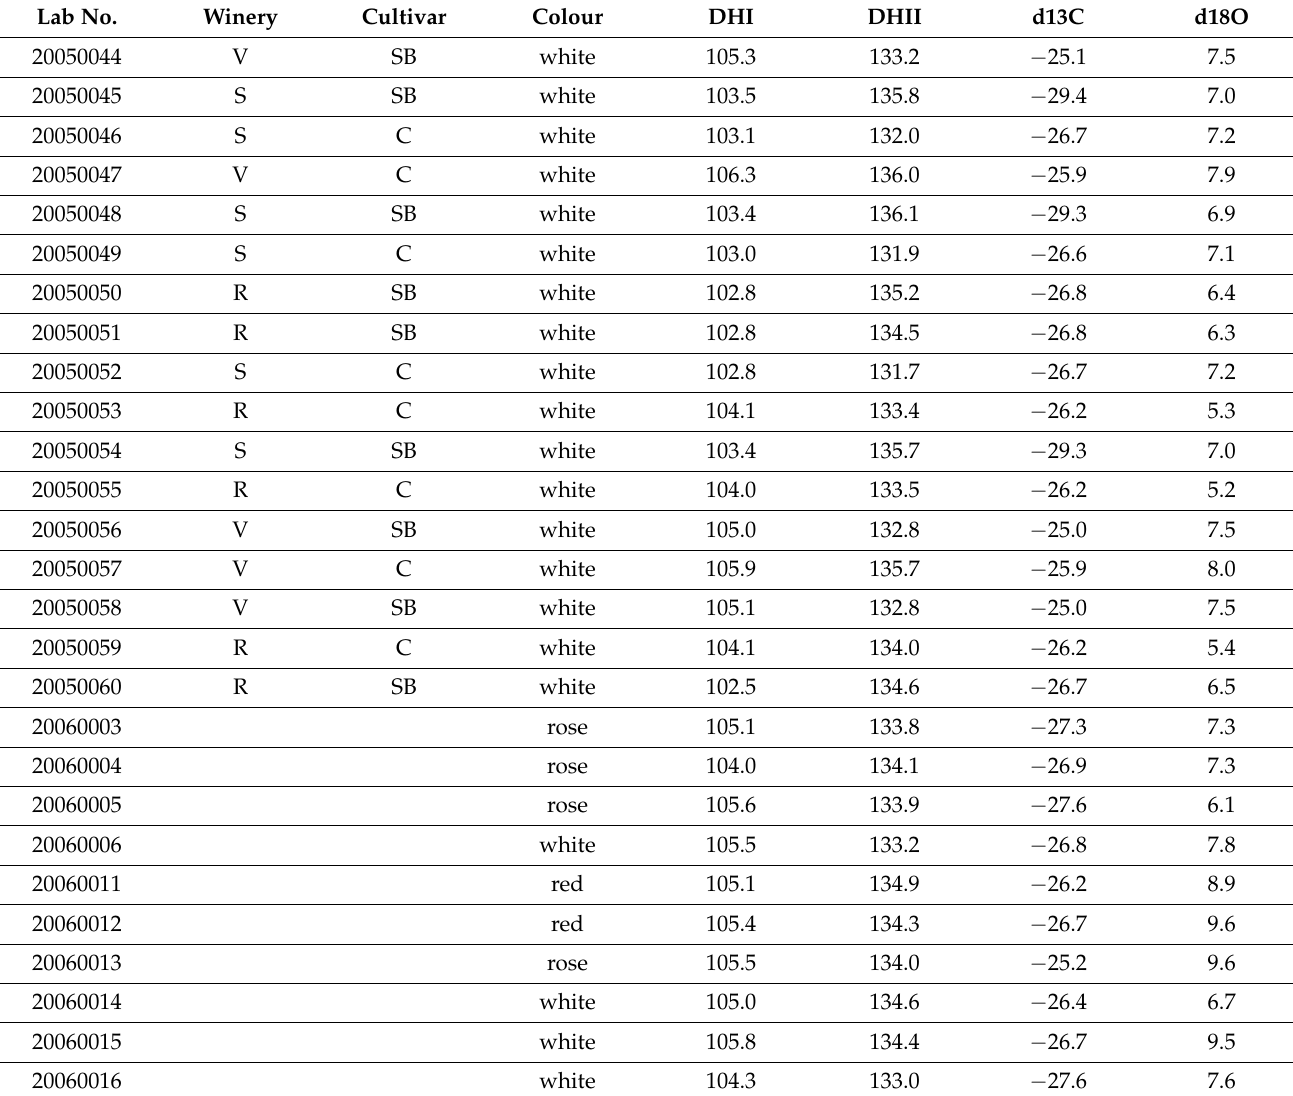
Table 1. South African wine samples analyzed in this study. V, S, R: Abbreviations of individual wineries from the Stellenbosch area. SB: Sauvignon blanc, C: Chenin blanc. Colours mark individual wineries. DHI = (D/H)I, DHII = (D/H)II, d13C = δ 13 C, d18O = δ 18 O. For more explanations